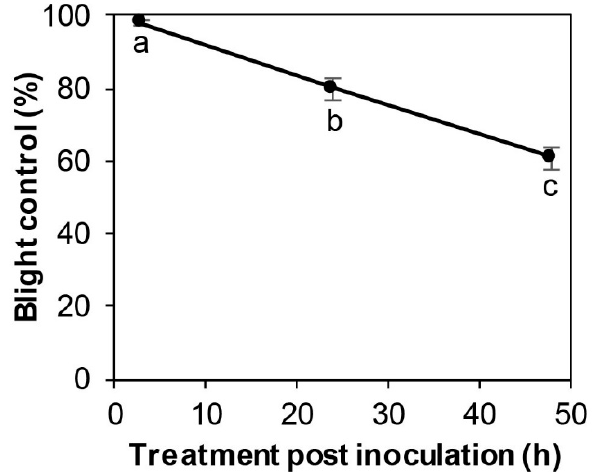
Figure 5. Blight control by SSG at 10 8 cfu/mL decreased with increasing treatment time post inoculation with Calonectria pseudonaviculata at 10 4 conidia/mL. Each data point is a mean blight control of six replicate Justin Brouwers boxwood plants from two experimental runs and is presented with a standard error bar. Data points marked with different letters differed according to the LSD test at p = 0.05.